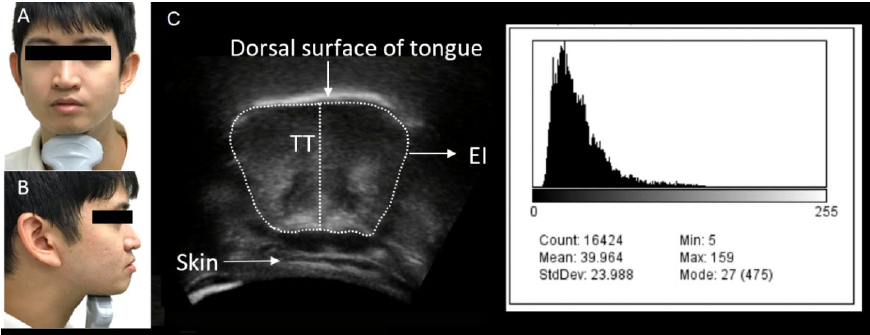
Figure 1. Points of measurement. ( A ) Position of the ultrasonography probe (anterior view). ( B ) Position of the ultrasonography probe (lateral view). ( C ) Ultrasonographic image and grayscale histogram of the tongue.